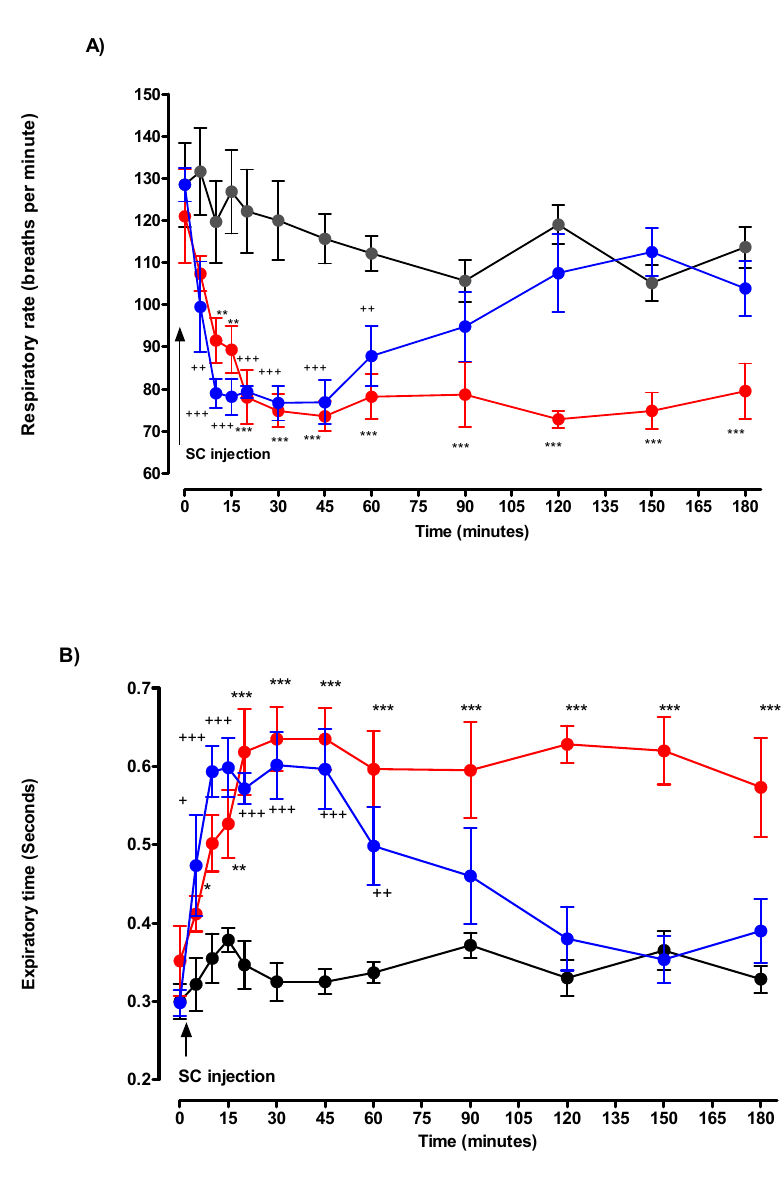
Figure 3. Effects of solvent (black circle), DMPO 50% MLD50 (blue circle), and DEPO 50% MLD50 (red circle) on the ( A ) respiratory rate and ( B ) expiratory time. Arrow denotes the time of injection of solvent, DMPO or DEPO. Each group consisted of six rats. Data are represented by mean ± SEM at each time after injection. DMPO vs. control: + p < 0.05, ++ p < 0.01, and +++ p < 0.001. DEPO vs. control: * p < 0.05, ** p < 0.01, and *** p < 0.001.